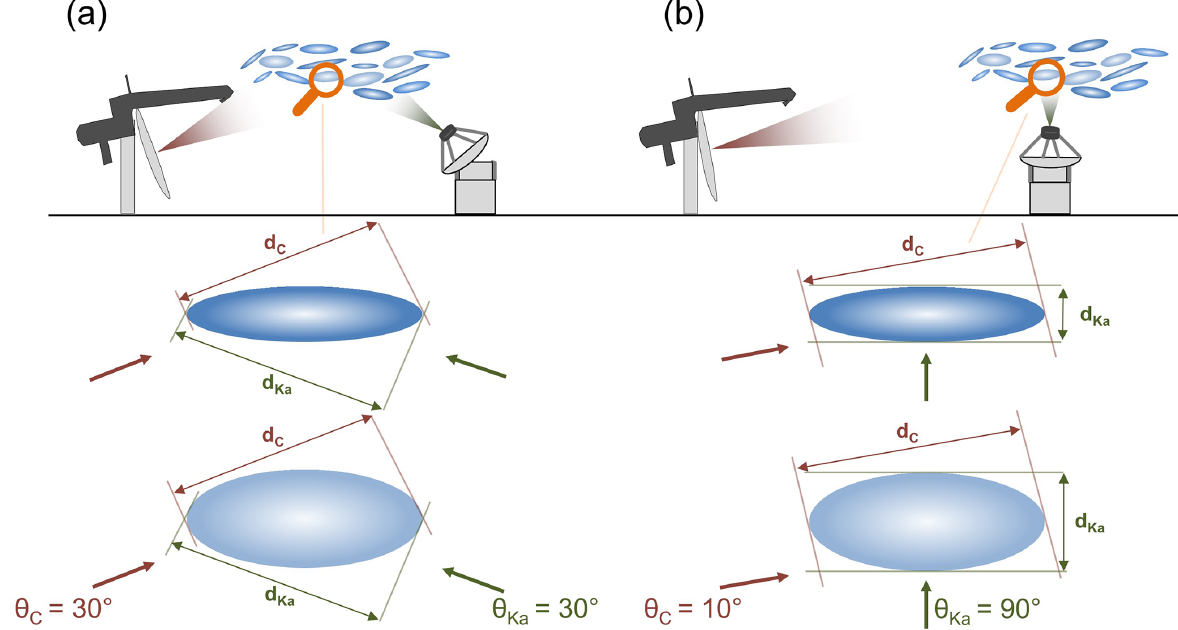
Figure 19. Radar beam geometries through oblate ice spheroids with different AR values for (a) θ C = θ Ka = 30 ◦ and (b) θ C = 10 ◦ , with θ Ka = 90 ◦